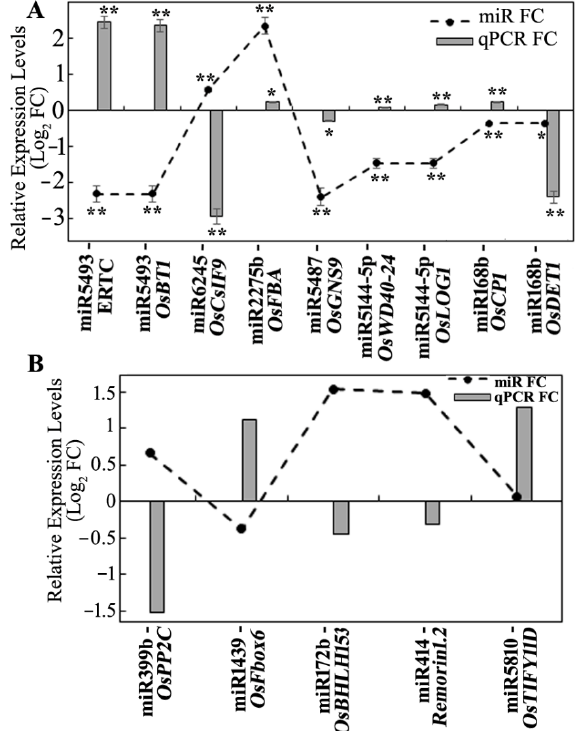
Figure 9. Expression analysis of miRNAs and their targets known to be involved in abiotic stress, light signaling, and shade tolerance. ( A ) Relative expression levels of DEm–target pairs are represented as Log 2 FC obtained with qRT-PCR. Each data point is a mean of 2 biological replicates performed in triplicate, and the error bar represents the standard error of the mean. * and ** represent significance at p ≤ 0.5 and p ≤ 0.01, respectively. ( B ) Relative expression levels of DEms were obtained from miRNA sequencing. Corresponding targets were identified by degradome sequencing. Transcription expression of these targets were filtered from microarray expression data. Relative expression levels of DEm–target pairs are represented as Log 2